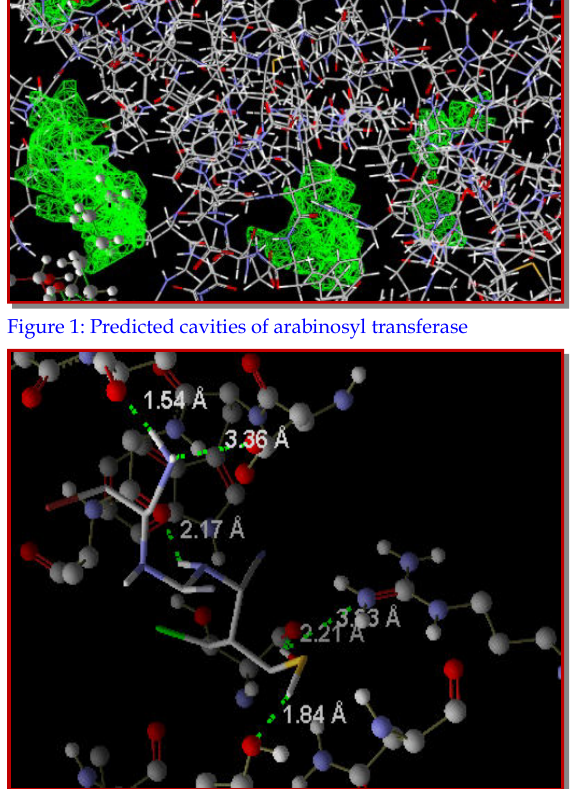
Figure 2: Receptor-ligand H bond